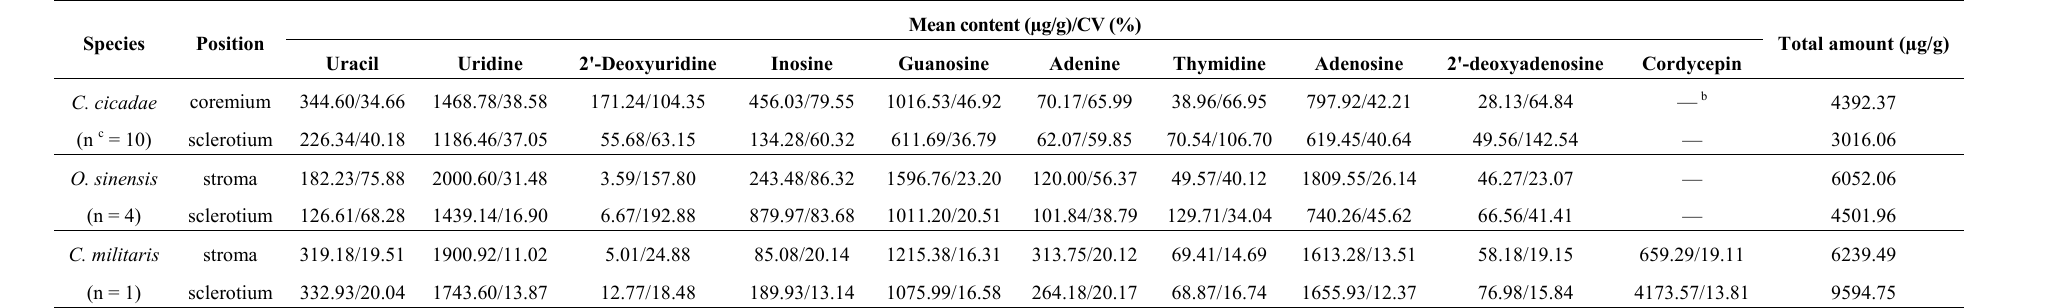
Table 3. The average content (µg/g) and CV (%) of 10 nucleosides in C. cicadae , O. sinensis and C. militairis